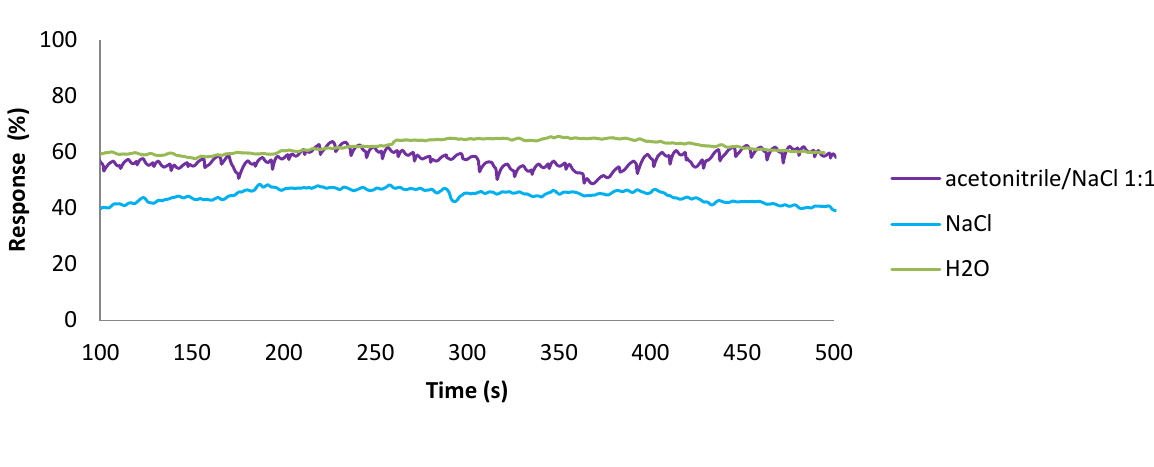
O); A homogeneous mixture 2